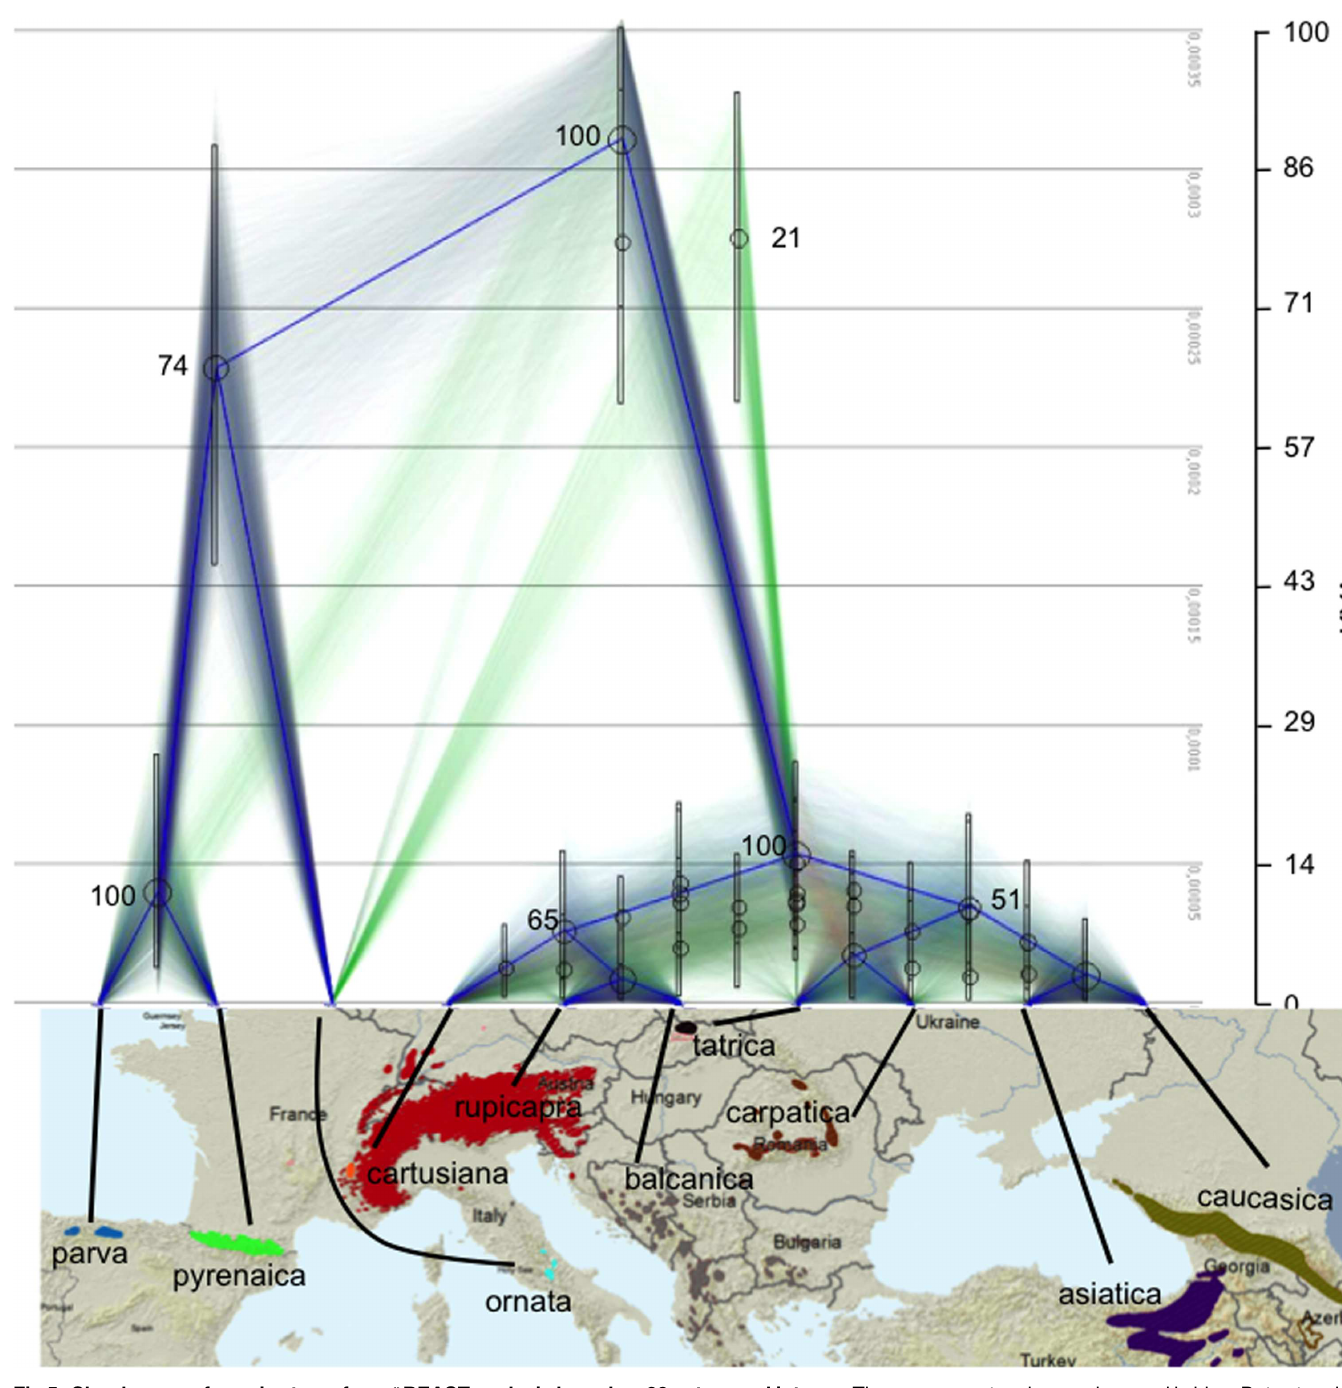
Fig 5. Cloudogram of species trees from * BEAST analysis based on 23 autosomal introns. The consensustree is superimposed in blue. Dots at nodes indicateposterior support that is also indicatedfor major nodes. Node bars correspondto 95% credibilityinterval (95% HDP) times of